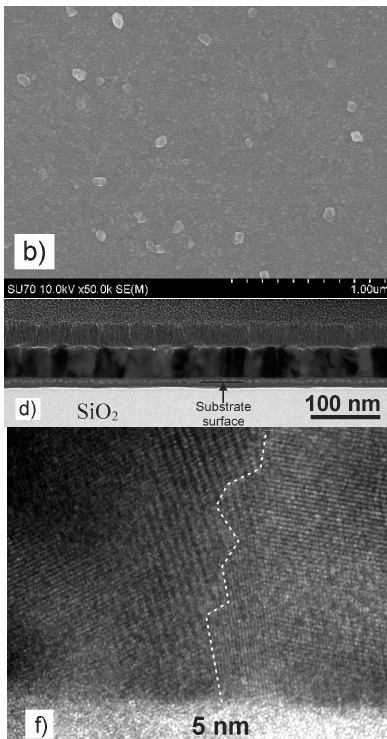
Figure 6. SEM surface images of 60 nm-thick LSMO films grown on different substrates: quartz ( a ), Si/SiO 2 substrates ( b ). Low-resolution TEM images of films grown on quartz ( c ) and Si/SiO 2 ( d ). High-resolution TEM images of an interface between intermixed layer (near the substrate) and two adjacent LSMO grains (( e )—film on quartz, ( f )—film on Si/SiO 2 ). The dotted lines show the grain boundaries.